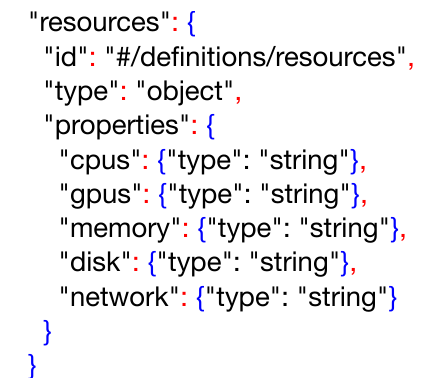
Figure 15. A snippet of the JSON schema definition for PADL